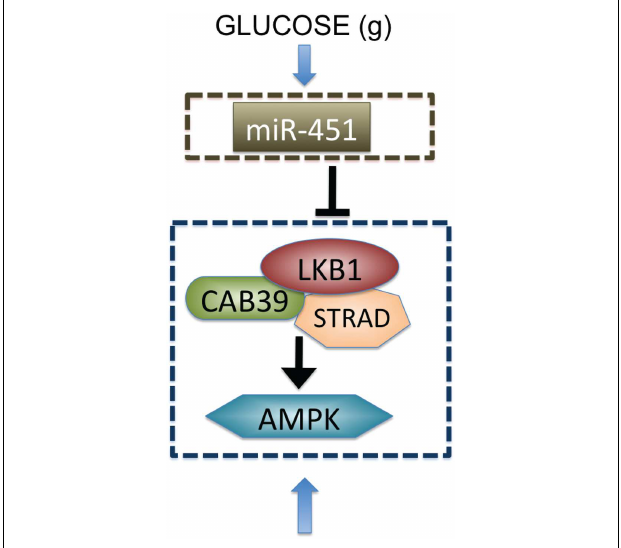
FIGURE 1 | Biological observation for regulation of miR-451-AMPK complex (Godlewski et al.,